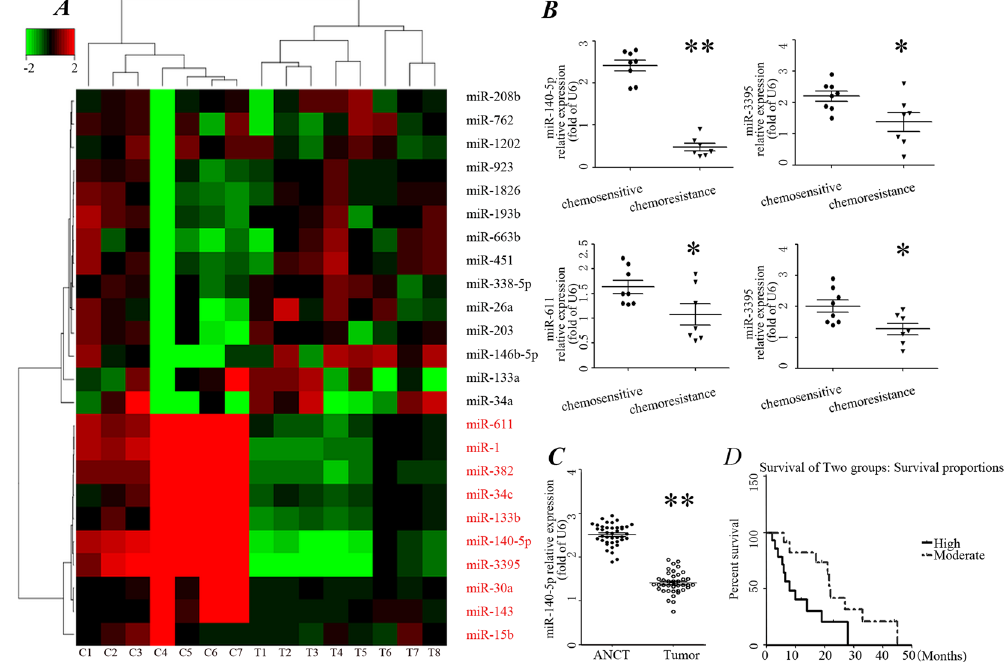
Figure 1. miR-140-5p lowly expressed in chemoresistance chort. ( A ) Heatmap representation of differentially expressed microRNAs in the chemoresistant osteosarcoma cases and chemosensitive osteosarcoma cases. Rows, miRNA; columns, independent biological replicates. Downregulated microRNAs are shown in red, while upregulated microRNAs are shown in green. ( B ) Differentially expressed microRNAs between chemoresistant osteosarcoma cases and chemosensitive osteosarcoma. Expression of miR-140-5p ( C ) in 40 paired osteosarcoma and adjacent normal bone tissues (ANCT). ( D ) Kaplan-Meier analysis for overall survival in 40 osteosarcoma patients in low- and moderate- groups based on miR-140-5p expression